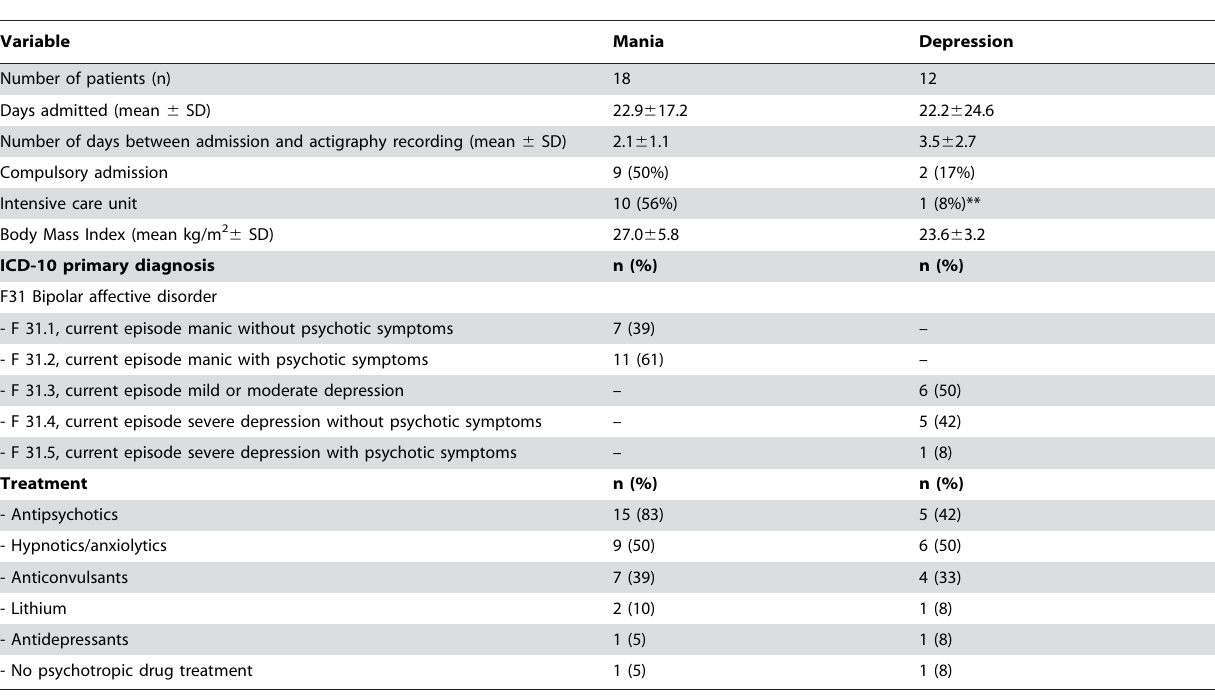
Table 2. Patient characteristics, groups according to current episode.